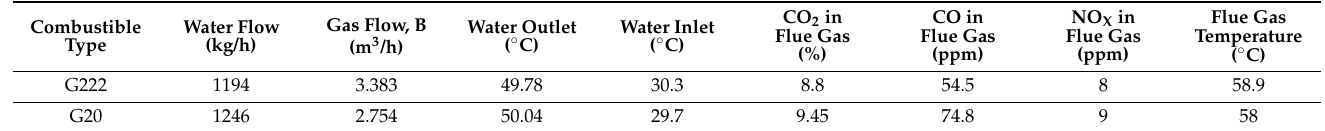
Table 6. Experimental average values for the 50/30 ◦ C condensation regime.